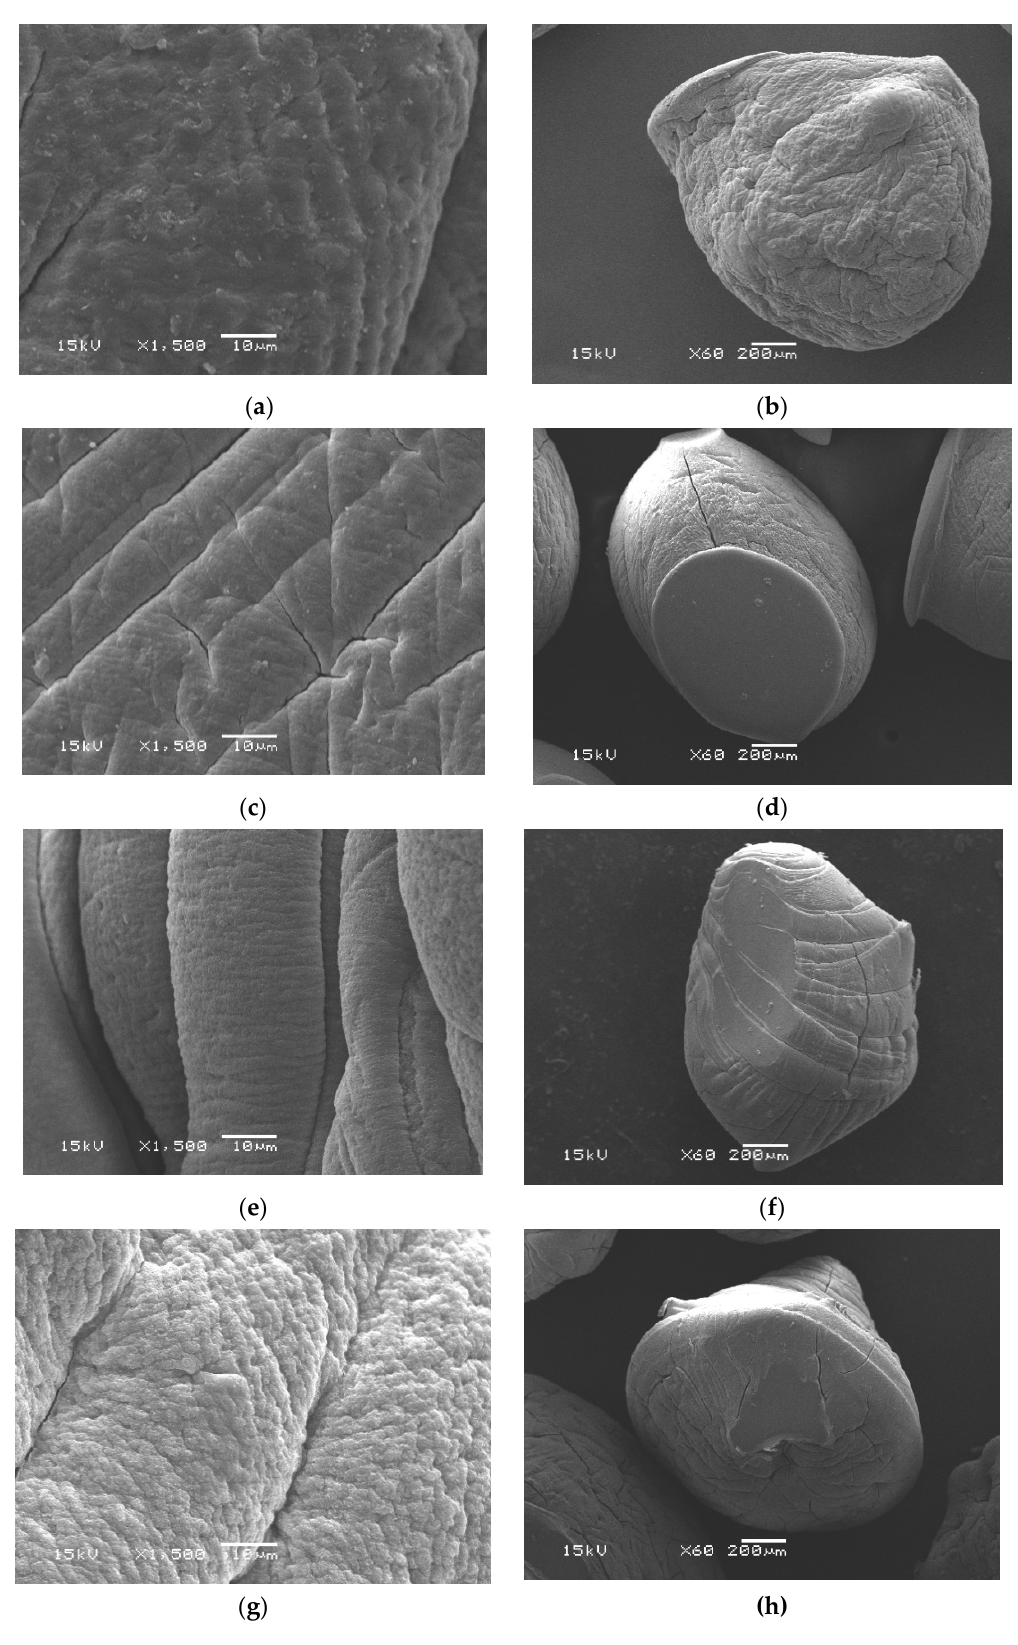
Figure 3 . SEM images of fracture and whole surface of (a, b) Alg (S0), (c, d) Alg-CMCs (S2), (e, f) Alg-CMCs@AmCs (S4) Figure 3. SEM images of fracture and whole surface of ( a , b ) Alg (S0), ( c , d ) Alg-CMCs (S2), ( e , f ) Alg-CMCs@AmCs (S4) and and (g, h) Alg-CMCs@AmCs (S5). ( g , h ) Alg-CMCs@AmCs